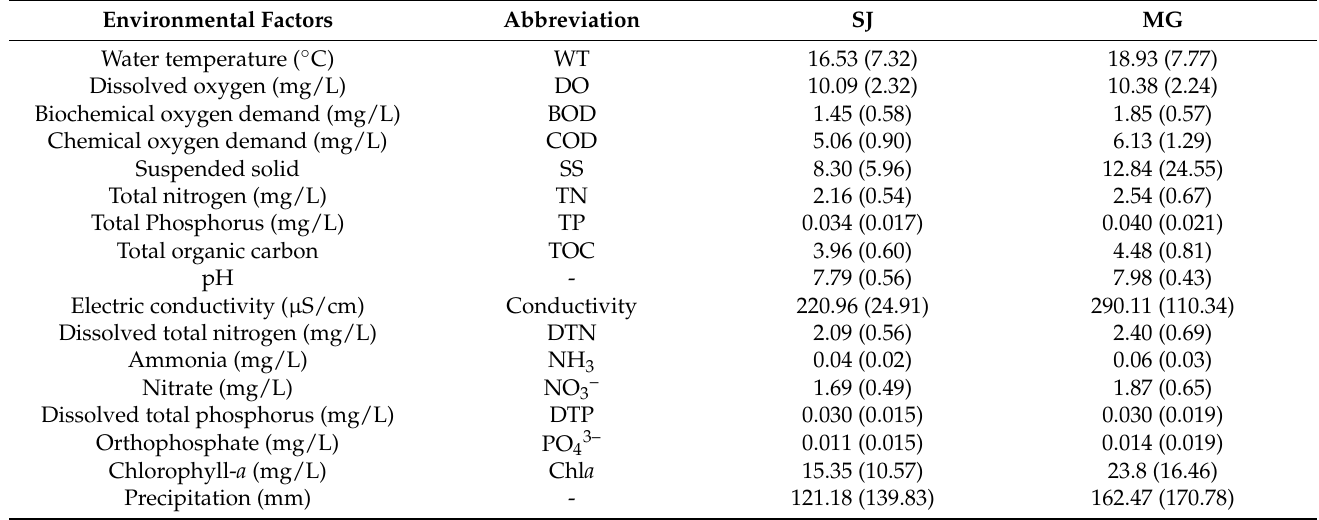
Table 1. Average values and standard deviation of the environmental variables at the sampling